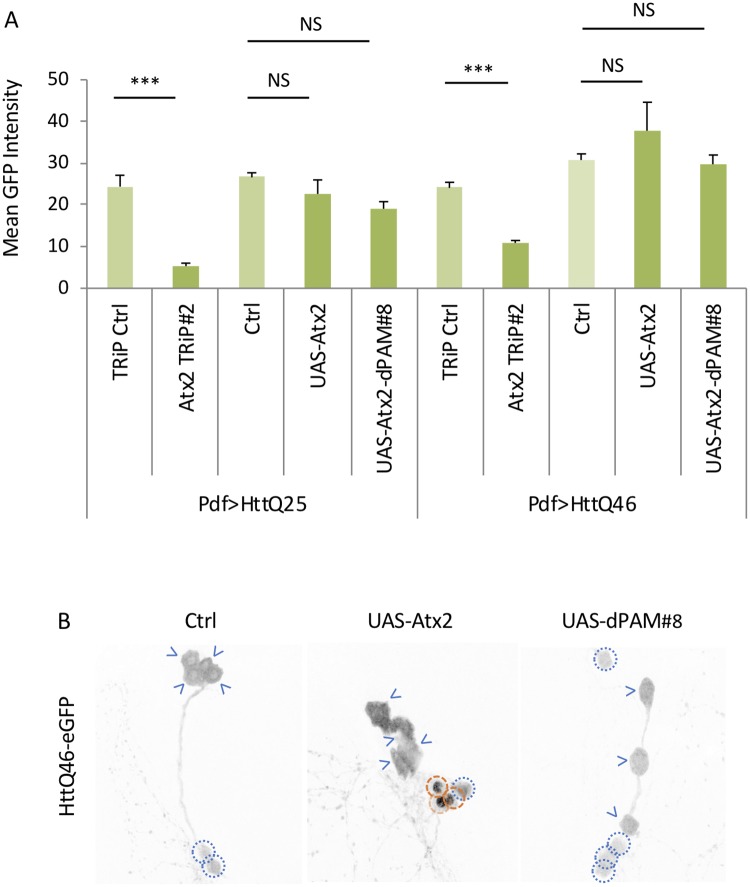
Atx2 knockdown decreases Htt and mHtt levels while Atx2 or Atx2-dPAM overexpression does not affect Htt or mHtt levels prior to aggregation formation.A. GFP Intensity in the sLNv for flies expressing HttQ25 (Q25) or HttQ46 (Q46) in a TRiP RNAi library control background (TRiP Ctrl#2) and expressing Atx2 RNAi lines (Atx2 TRiP #2) at age day 5 is quantified and shown. GFP Intensity in the sLNv without aggregates formed for flies expressing HttQ25 (Q25) or HttQ46 (Q46) in a wild-type control background (Ctrl) and expressing UAS-Atx2 and UAS-dPAM at age day 2 is quantified and shown (n = 5–38; *p<0.05, **p<0.01, ***:p<0.005). B. Representative images of LNvs (sLNv and lLNv) expressing HttQ46-eGFP at age day 2 are shown in wild-type control background (Ctrl) and overexpressing Atx2 or Atx2 lacking the PAM domain (UAS-dPAM). Blue arrowheads indicate lLNvs. Blue circles label sLNvs without aggregates. Orange dash circles label sLNvs with nuclear accumulation/aggregation of HttQ46 (which were not used for GFP intensity quantification).